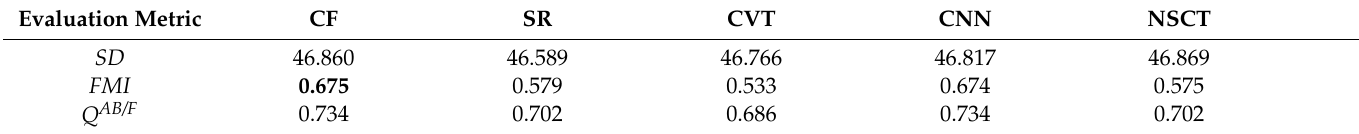
Table 11. The outcomes for the desk image and comparisons with existing techniques in the literature ([24]).